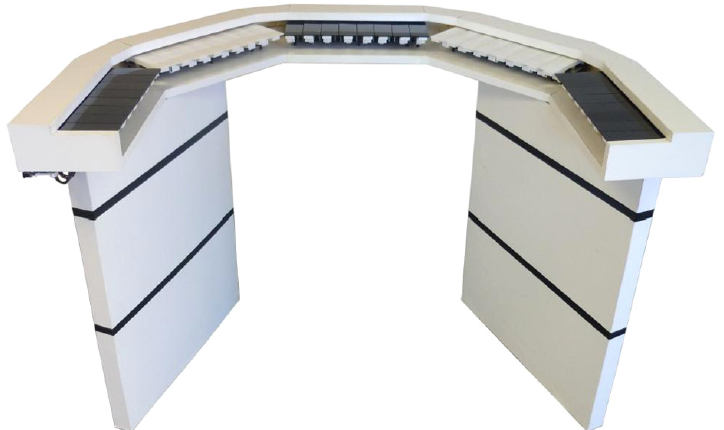
Figure 8. The Vibrochord, a vibrotactile musical input device VMID, retrieved from